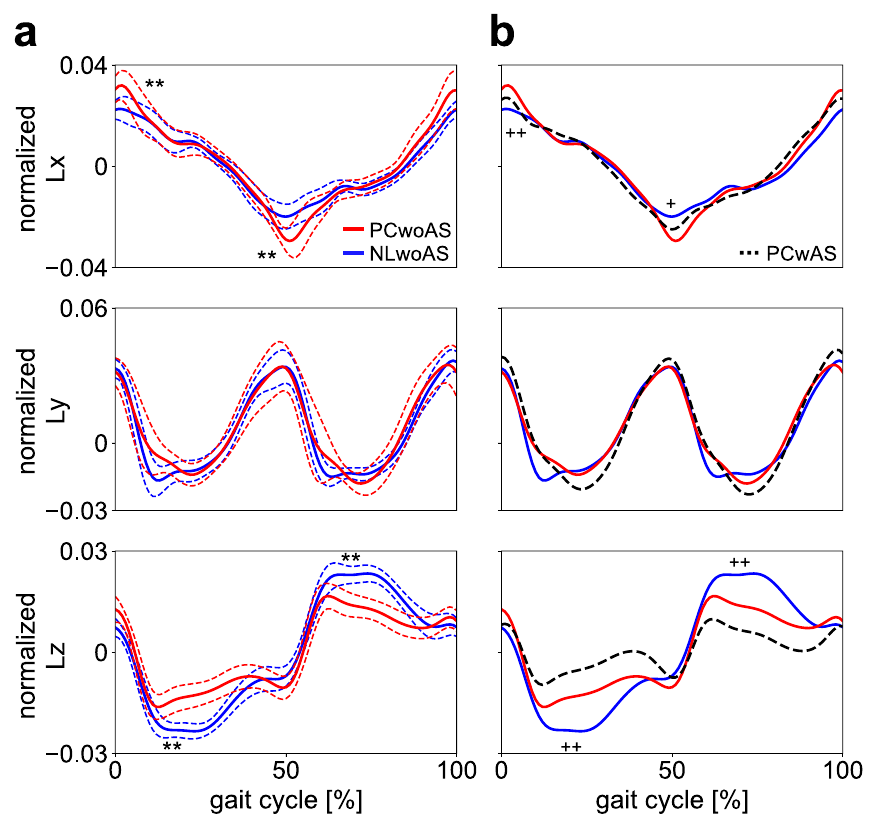
Figure 4. Mean normalised WBAM profiles of the body COM during walking with the NL and PC shoes when the arm swing was restrained (NLwoAS and PCwoAS, respectively) ( a ). Mean profiles were also compared with those with the PC shoes when the arm swing was not restrained (PCwAS) ( b ). Blue solid line = NLwoAS, Red solid line = PCwoAS. Corresponding dashed lines represent standard deviations. Black dashed line = PCwAS. Asterisks indicate statistical differences of the maximum or minimum values between NLwoAS and PCwoAS (*: p < 0.05. **: p < 0.01). Pluses indicate statistical differences between NLwoAS and PCwAS (+: p < 0.05. ++: p <